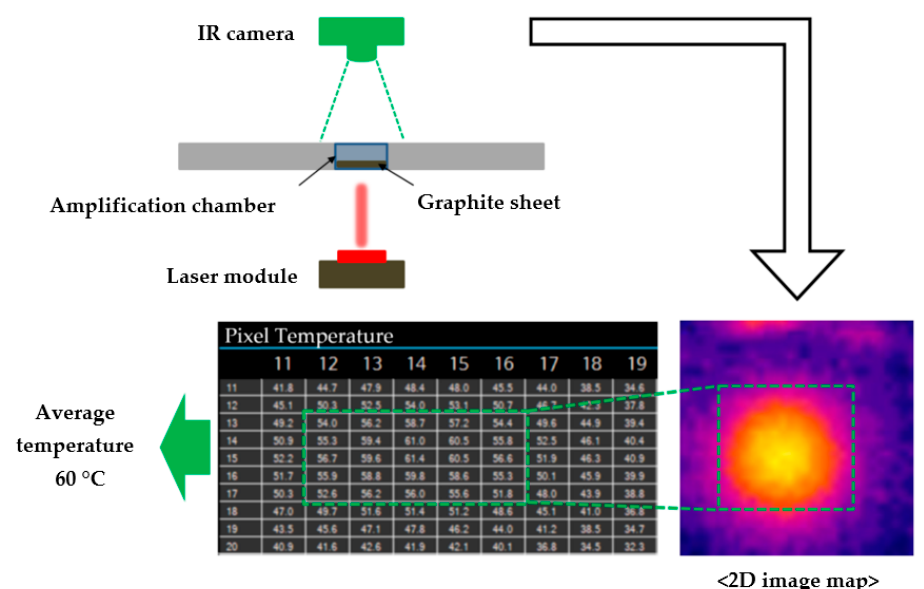
Figure 7. Two-dimensional image map to measure the average temperature of the amplification chamber. The image map was obtained from the IR camera installed above the LOD, and the graphite sheet inside the chamber efficiently absorbed the laser beam. The laser module was turned on or off to maintain the average temperature of the chamber at 60 °C.